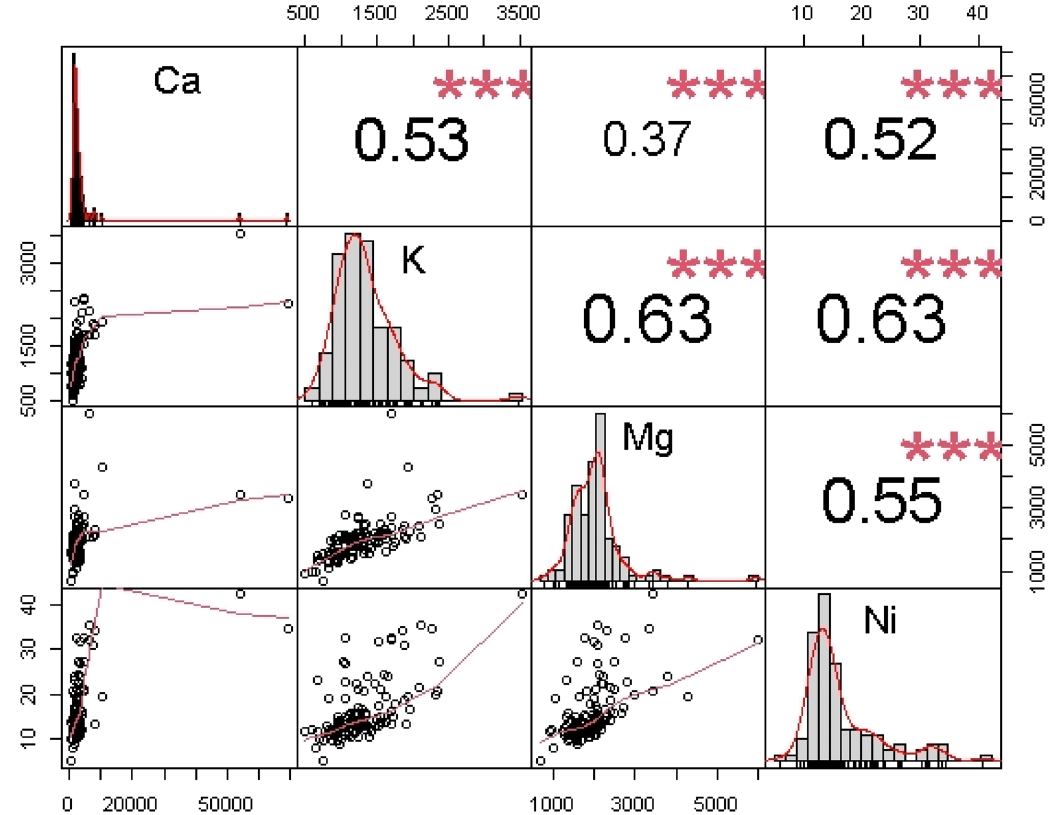
Figure 3. Correlation matrix of the elements showing the relationship between predictors and response (Note: The plot includes scatter plots between the element, and the significance levels is based on p <